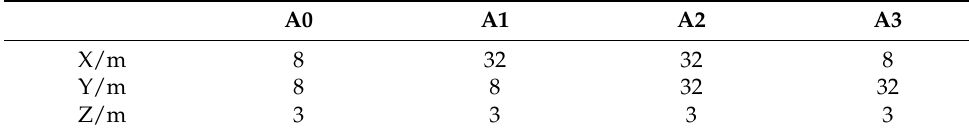
Table 1. Base station coordinates in a wide simulation space.